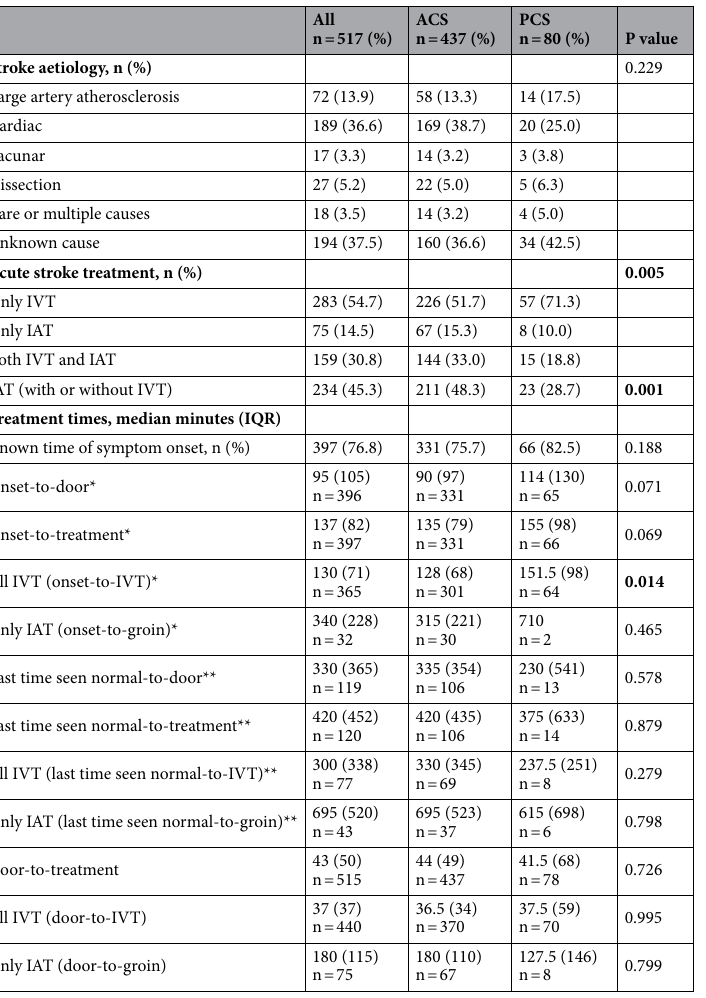
Table 2. Stroke aetiology and acute treatment information. Information on stroke aetiology and acute stroke treatment of all 517 patients and patient groups according to stroke territory, ACS and PCS. *Marked variables only contain patients with known symptom onset versus **unknown symptom onset. Data are expressed as number of patients (n) and percentages or median and interquartile range (IQR). IVT indicates intravenous thrombolysis; IAT, intra-arterial therapy. P values were obtained according to Mann–Whitney U test, Pearson’s Chi-squared test and Fisher’s Exact test, where appropriate. P values < 0.05 are shown in